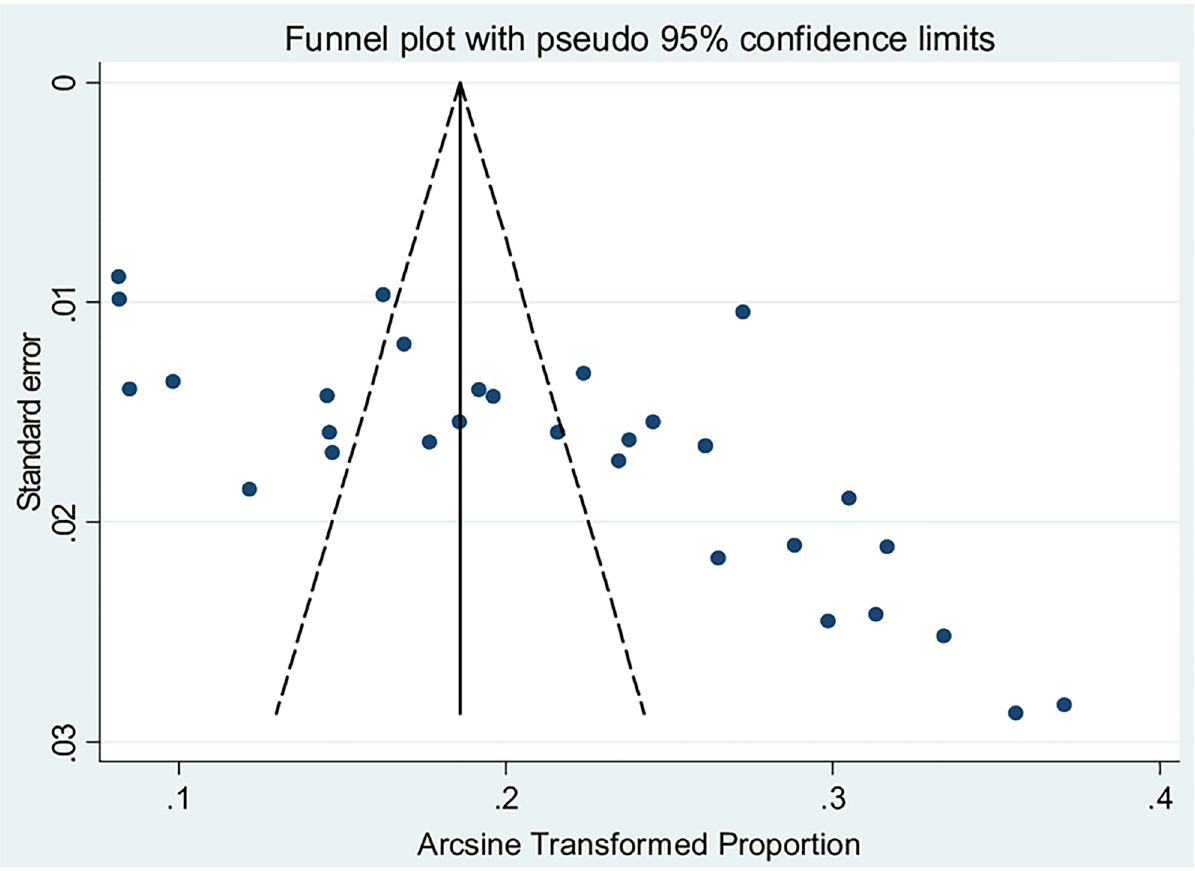
Fig 3. Funnel plot with 95% confidence limits of the pooled prevalence of diarrhea among under-five children in Ethiopia.